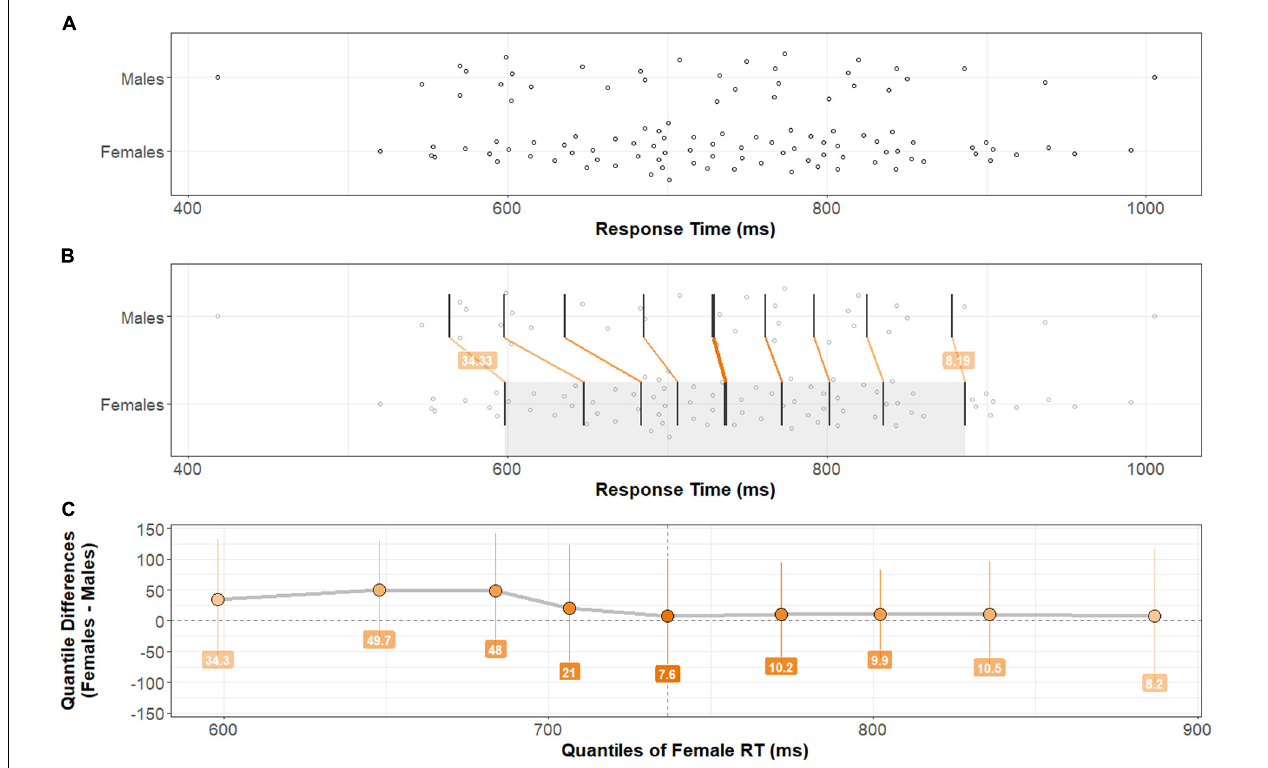
FIGURE 3 | Response Time distributions by group and comparison by shift function. (A) Stripchart of Response Time distributions (mean Response Time across Trial-types) for Males and Females. (B) Stripchart shown in (A) with quantiles and differences between distribution quantiles characterized (see Figure 2 caption for detailed explanation). (C) Shift function between Male and Female distributions. Note that bootstrapped 95% confidence intervals at each quantile difference point cross zero. There is no significant difference in Response Time across Task-types between Females and Males. Two-sample, two-sided Kolmogorov–Smirnov test: D = 0.17, p >